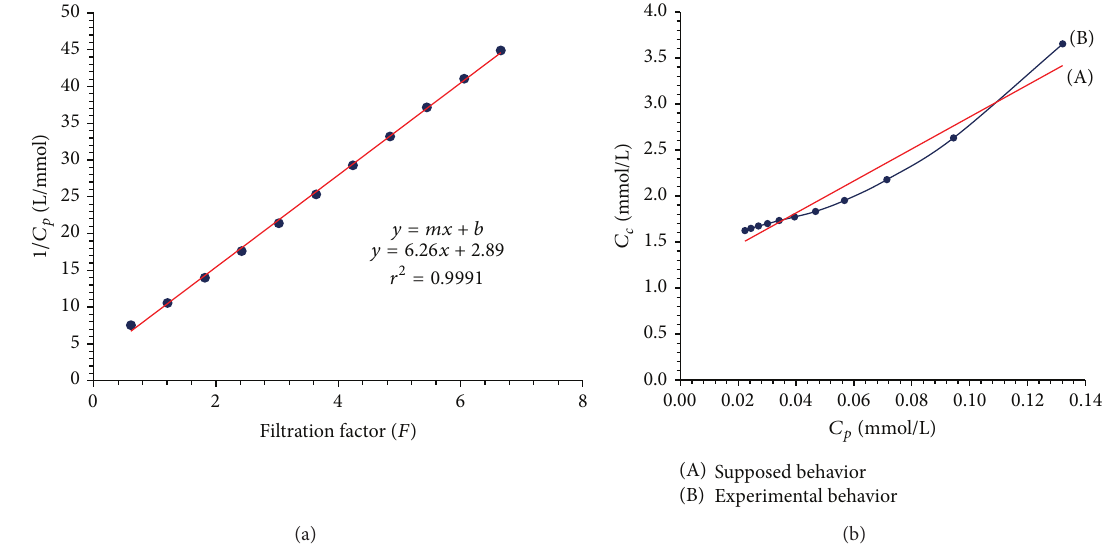
Figure 3: Description of experimental data by (19) (a) and evaluation of (3) from experimental data ( 𝐶 𝑐 and 𝐶 𝑝